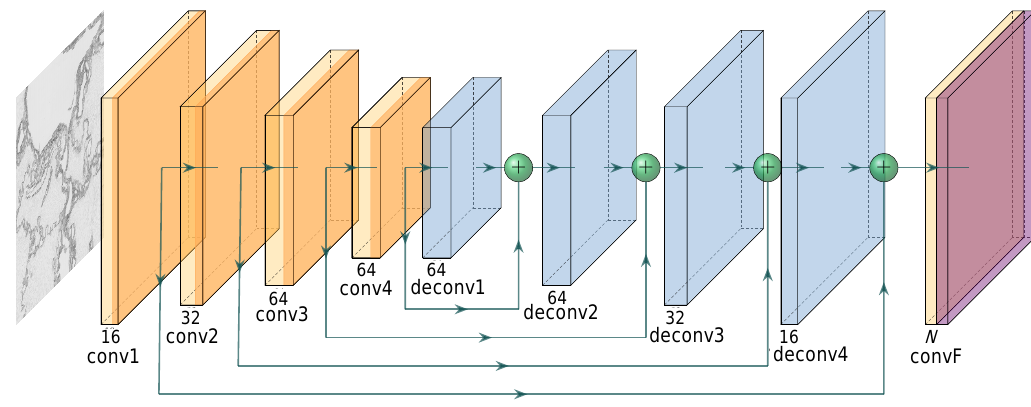
Figure 4. Structure of UNet-Mini architecture. The encoder is composed of four convolutional layers, each followed by batch normalization (BN) and the ReLU activation function. The decoder mirrors this structure. N in the last convolutional layer convF of the decoder represents the number of classes (i.e., 3). conF is followed by the Softmax